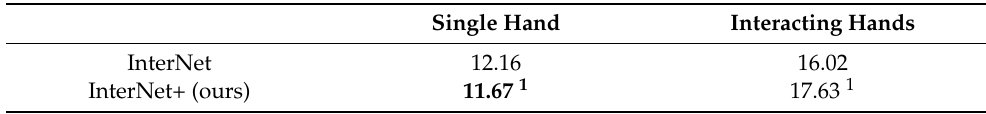
Table 5. Comparison of MPJPE (mean per joint position error) between our results and that of the original InterNet on the InterHand2.6M dataset.